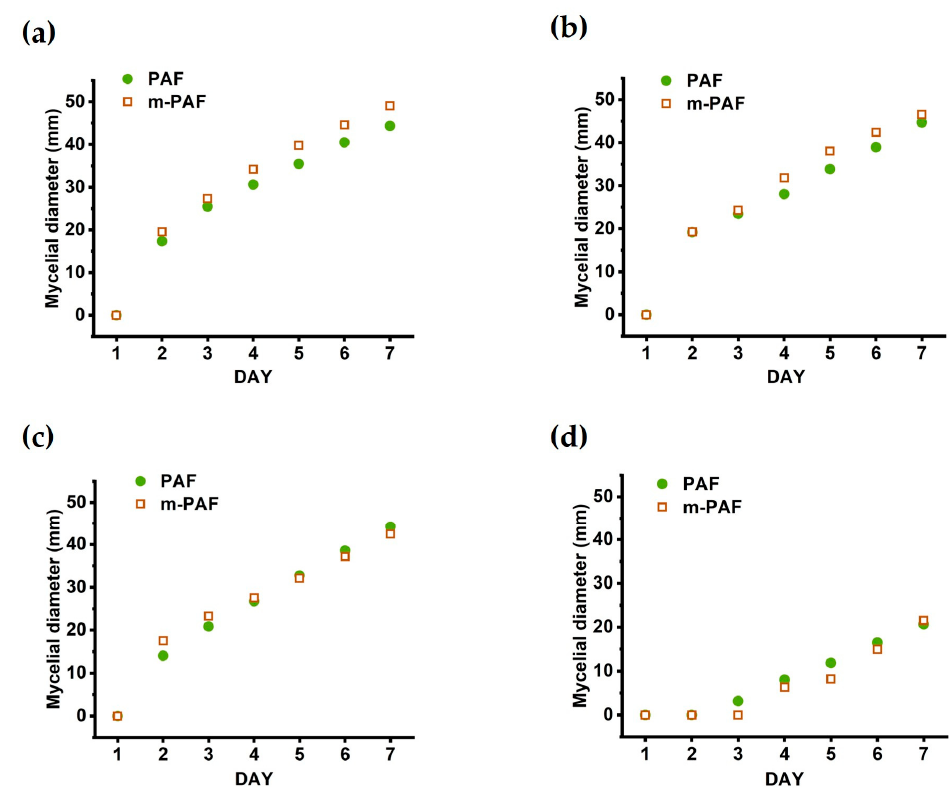
Figure 8. Comparative growth of A. niger in PAF and m-PAF mixed with ACV ( a ) 0% v / v ; ( b ) 0.3% v / v ; ( c ) 0.625% v / v ; ( d ) 1.25% v / v . Table 4. Reported antifungal activities of apple cider vinegars (ACVs) and vinegars produced from